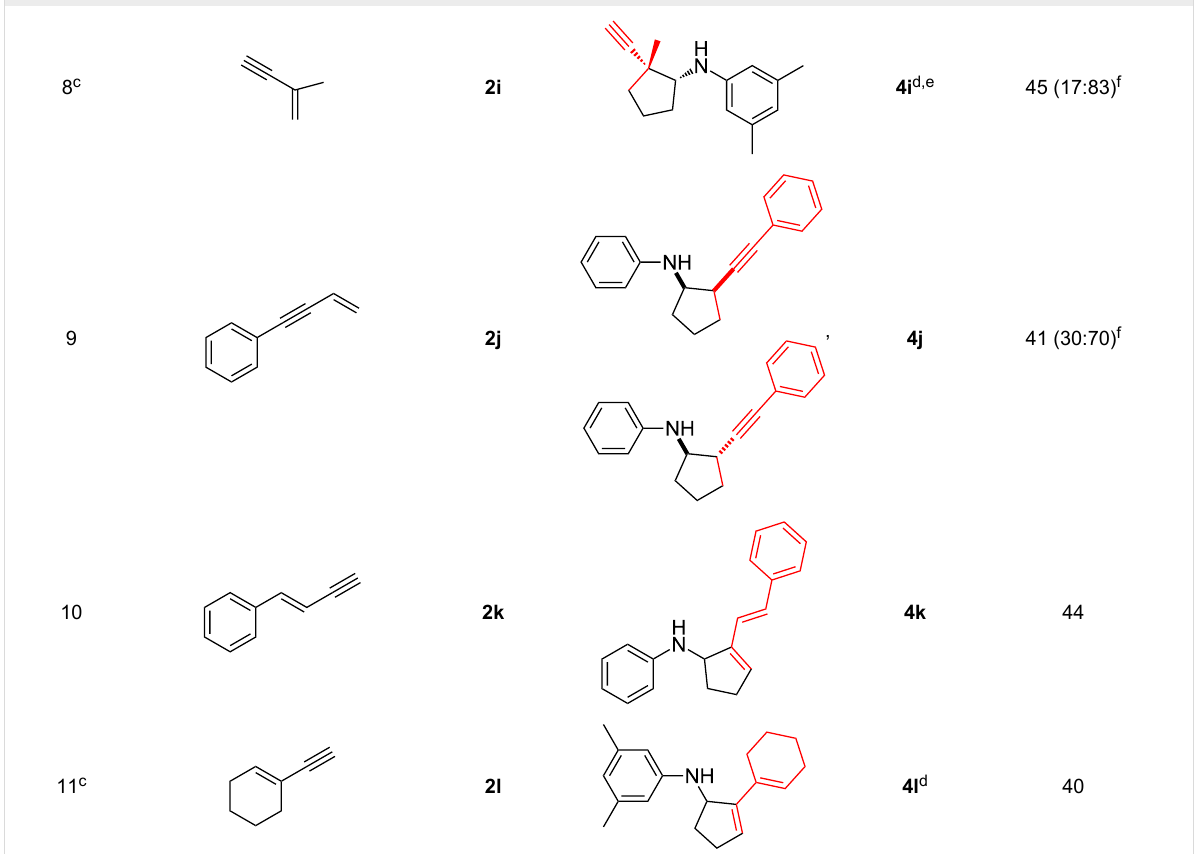
Table 3: Substrate scope of alkyne derivatives a .